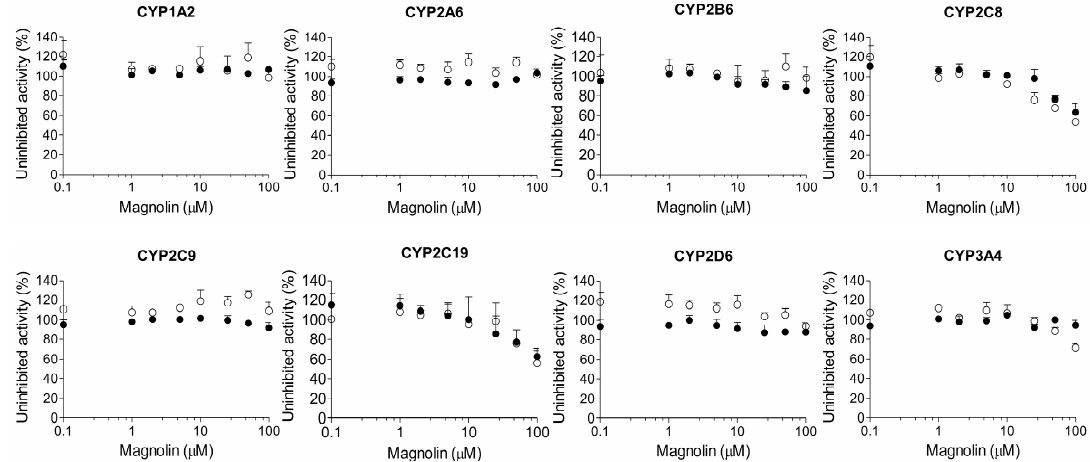
Figure 2. Inhibitory effects of dimethyllirioresinol on CYP1A2-mediated phenacetin O -deethylation, CYP2A6-mediated coumarin 7-hydroxylation, CYP2B6-mediated bupropion hydroxylation, CYP2C8-mediated amodiaquine N -deethylation, CYP2C9-mediated diclofenac 4’-hydroxylation, CYP2C19-mediated [ S ]-mephenytoin 4’-hydroxylation, CYP2D6-mediated bufuralol 1’-hydroxylation, and CYP3A4-mediated midazolam 1’-hydroxylation in pooled human liver microsomes. : Pre-incubation of liver microsomes with dimethyllirioresinol and reduced β -nicotinamide adenine dinucleotide phosphate (NADPH) for 30 min at 37 °C and : No pre-incubation. Data represent the average ± standard deviation (SD, n = 3). Magnolin, epimagnolin A, and eudesmin negligibly inhibited CYP1A2, CYP2A6, CYP2B6, CYP2C8, CYP2C9, CYP2C19, CYP2D6, and CYP3A4 activities at 100 μ M in human liver microsomes (Figures 3–5).